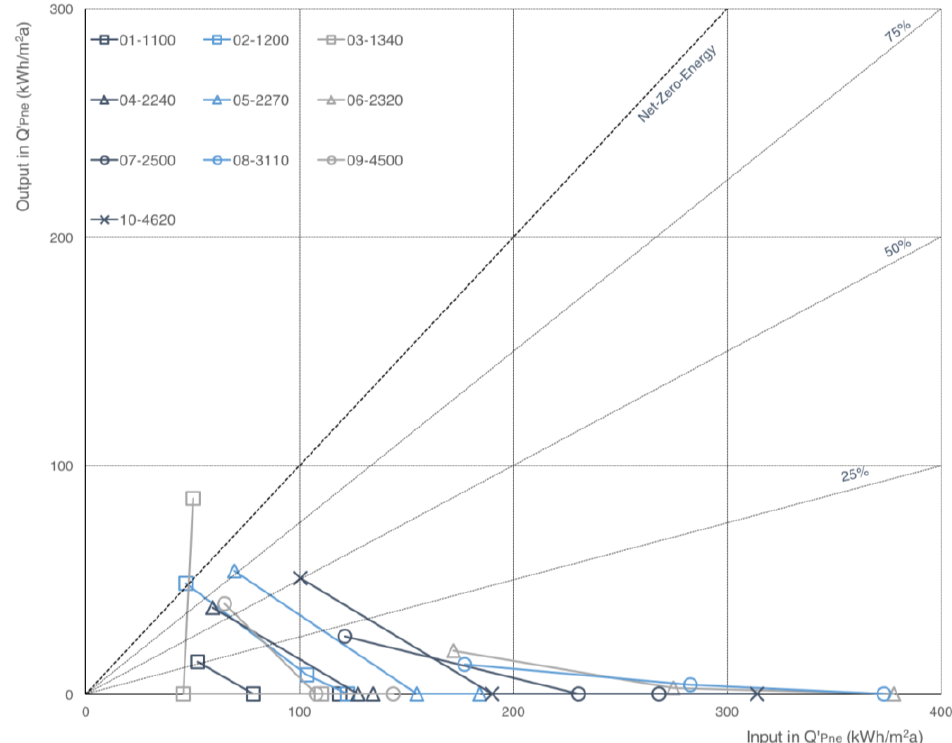
Figure 5. The results of all case studies—input-output balance (Q’ PNE (kWh/m 2 a)) of the energy standard’s reference building according to EnEV (right data point), standard case study (middle data point), and standard nZEB 2021 (left data point).